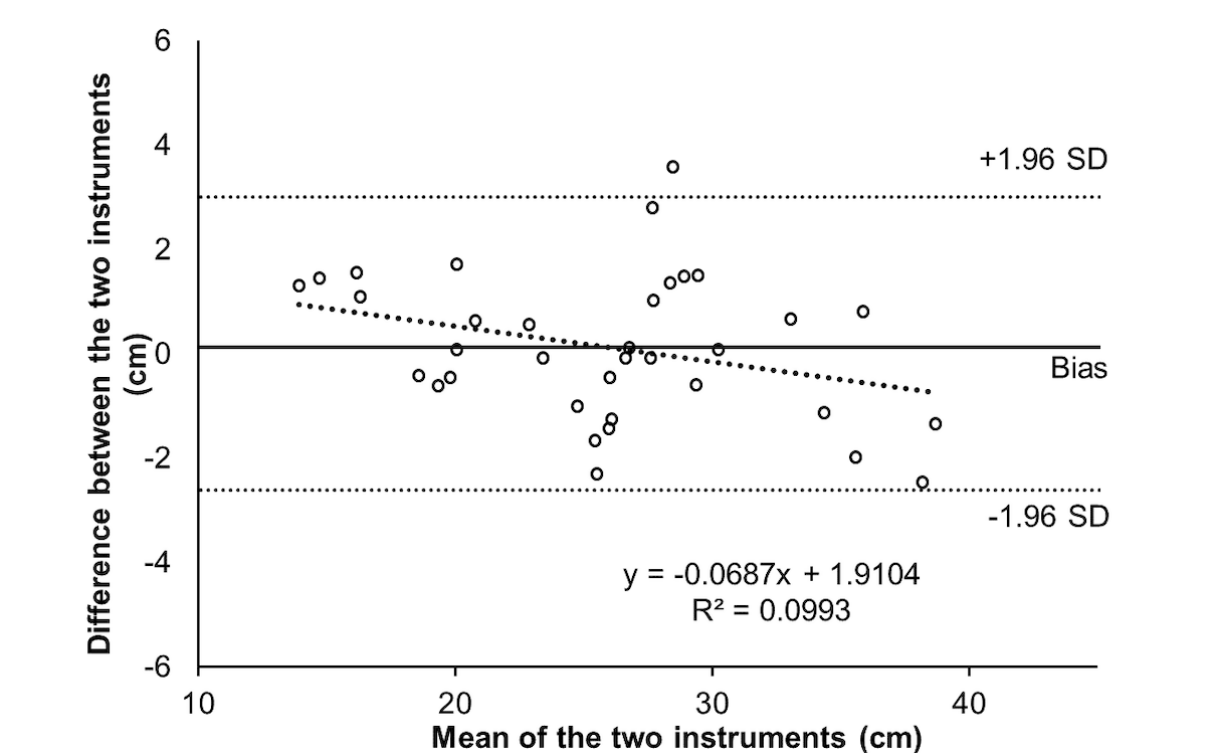
Figure 1. Bland-Altman for agreement analysis of squat